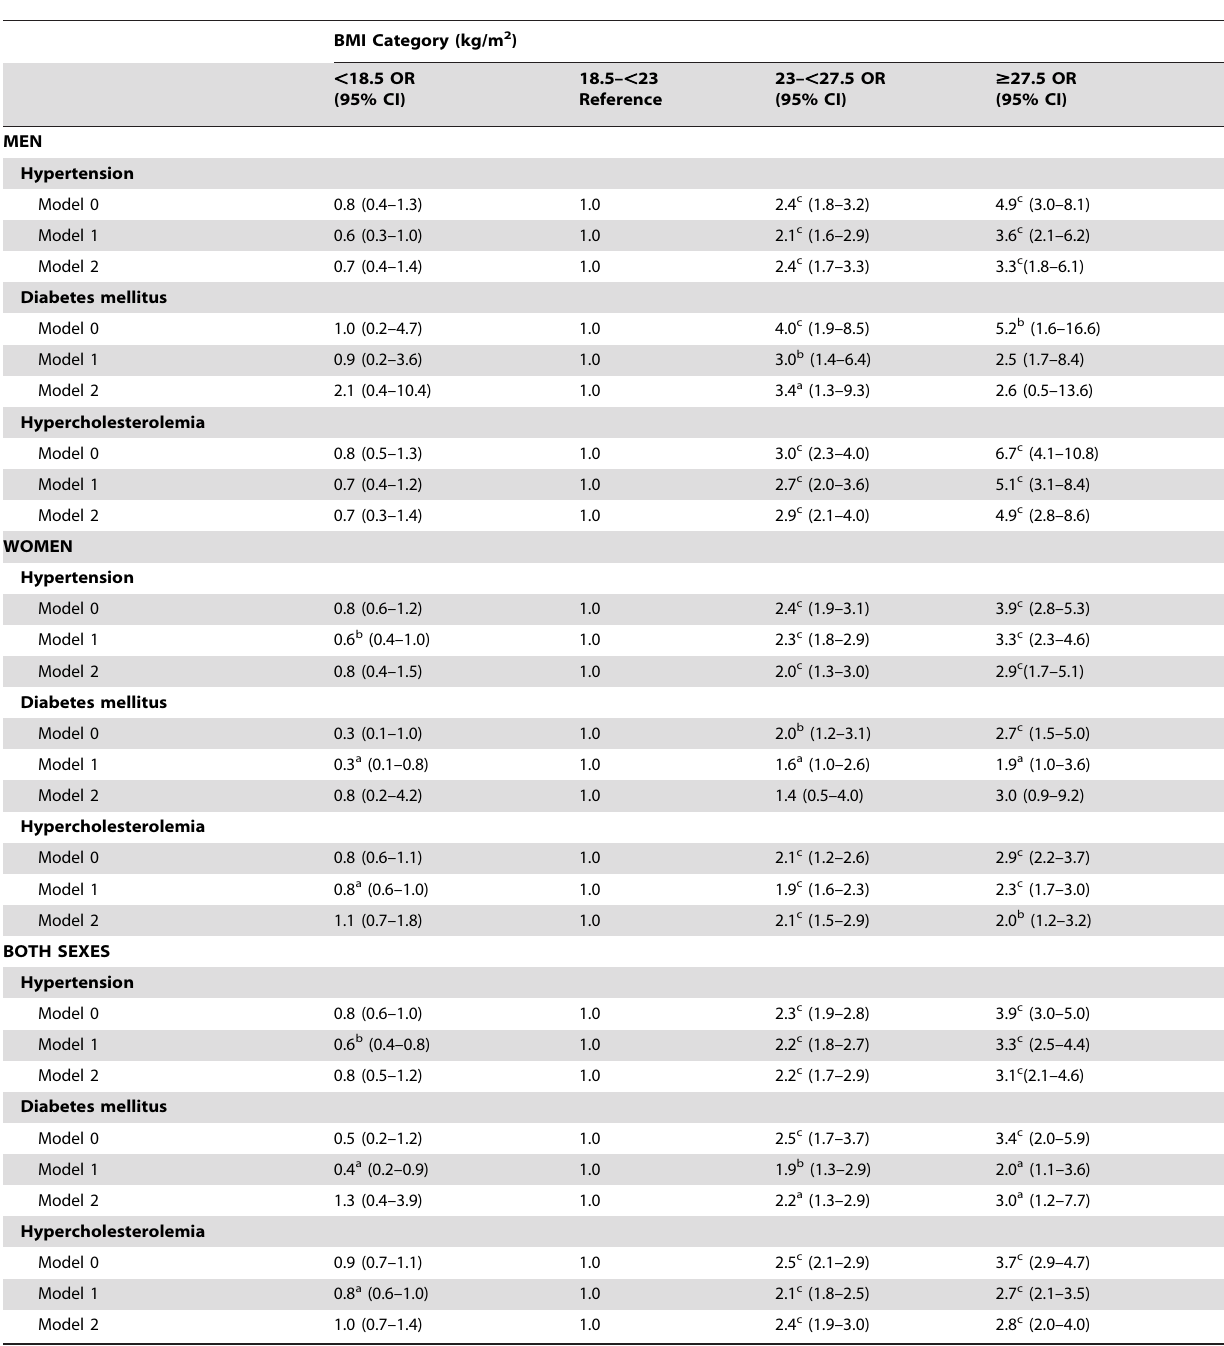
Table 3. Odd ratio (OR) of hypertension, diabetes mellitus and hypercholesterolemia across body mass index (BMI)